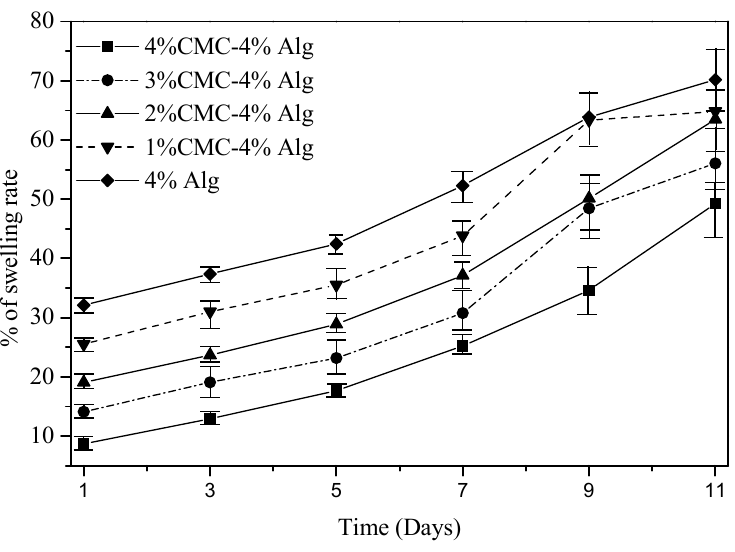
Figure 18. Swelling rate of different compositions of material.